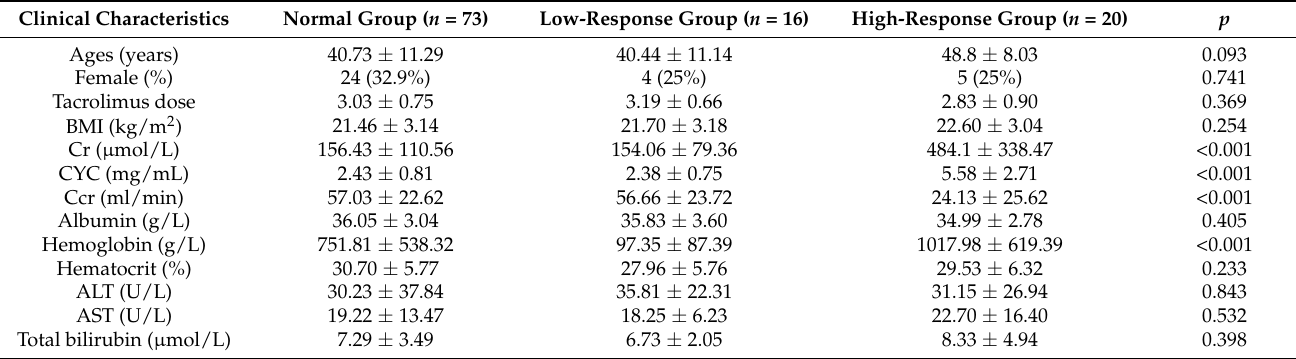
Table 1. Patient